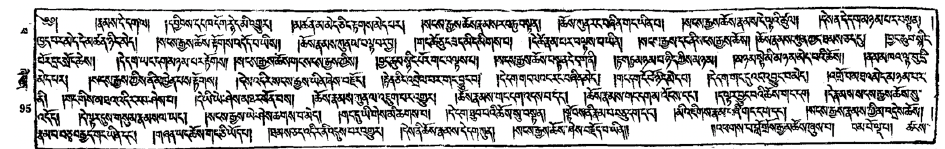
Figure A5. Tibetan translation of the Sgm. D152 mdo sde, pha 48a (Karmapa reprint 1976–79). Avail- able online at h tt p://www.rkts.org/images.php?id=1|D|MW22084|I0943|mdo%20sde|48a (ac- cessed on 15 March 2023).